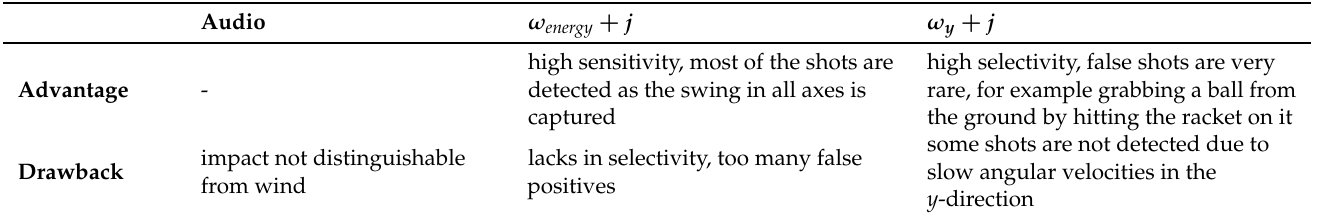
Table A1. Advantages and drawbacks of the previously introduced solutions for